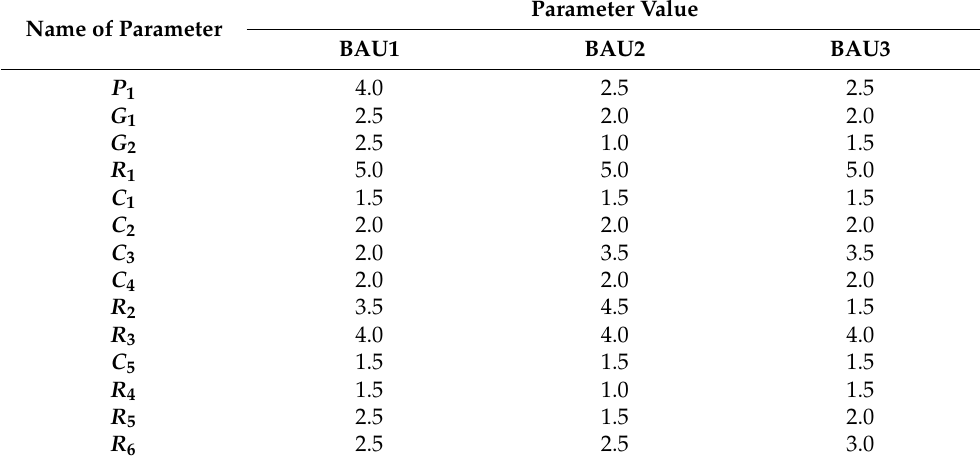
Table 6. Parameter